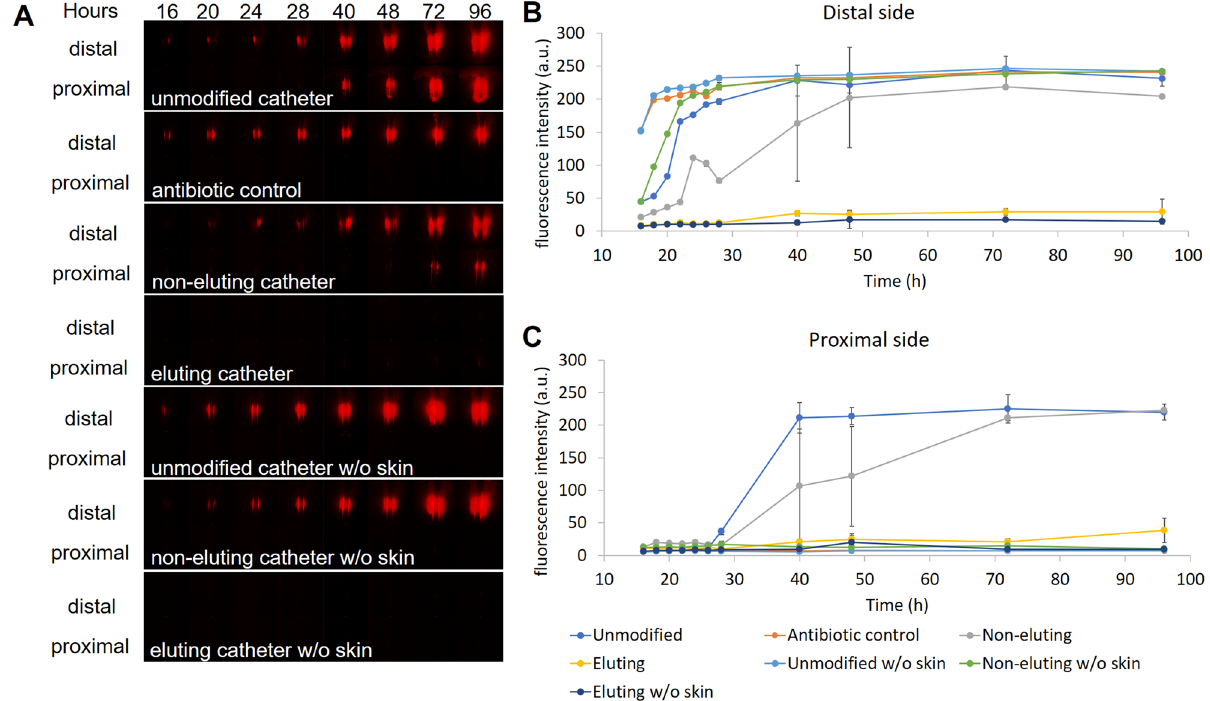
Figure 3. Migration of RP437/pRSH103 E. coli in ex vivo models at 16, 20, 24, 28, 40, 48, 72, and 96 h of incubation. ( A ) Fluorescence images of E. coli on both proximal and distal sides. ( B ) Time-dependence of integrated E. coli fluorescence intensity on the distal side. ( C ) Time-dependence of integrated E. coli fluorescence intensity on the proximal